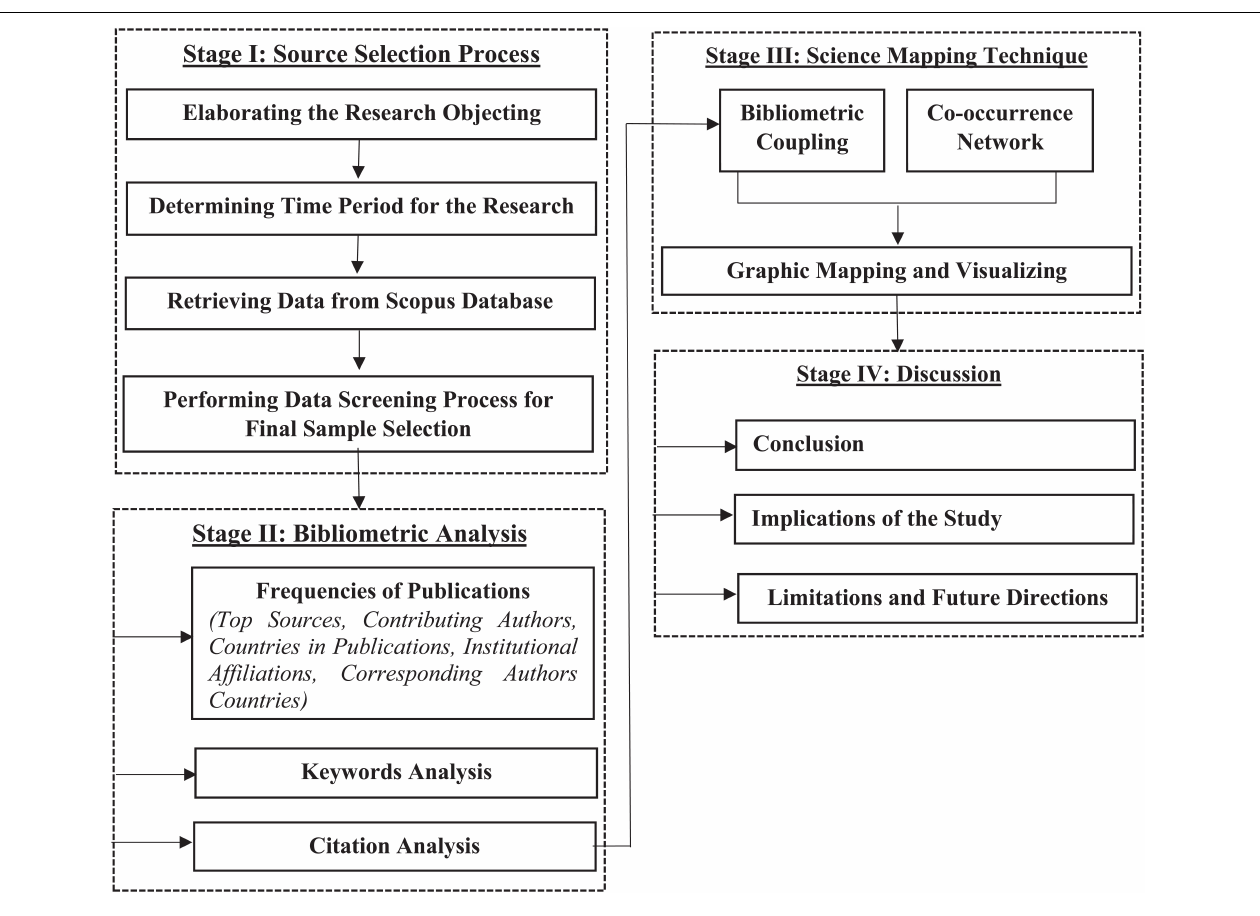
FIGURE 1 | Flow of